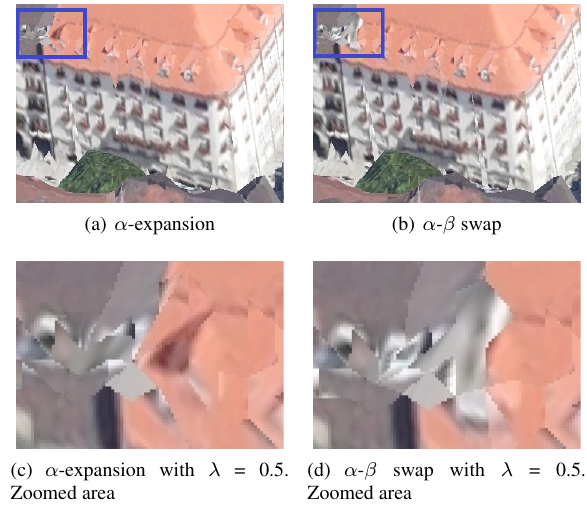
Figure 11. Comparison study between α -expansion and α - β swap performances ( λ = 0.5).